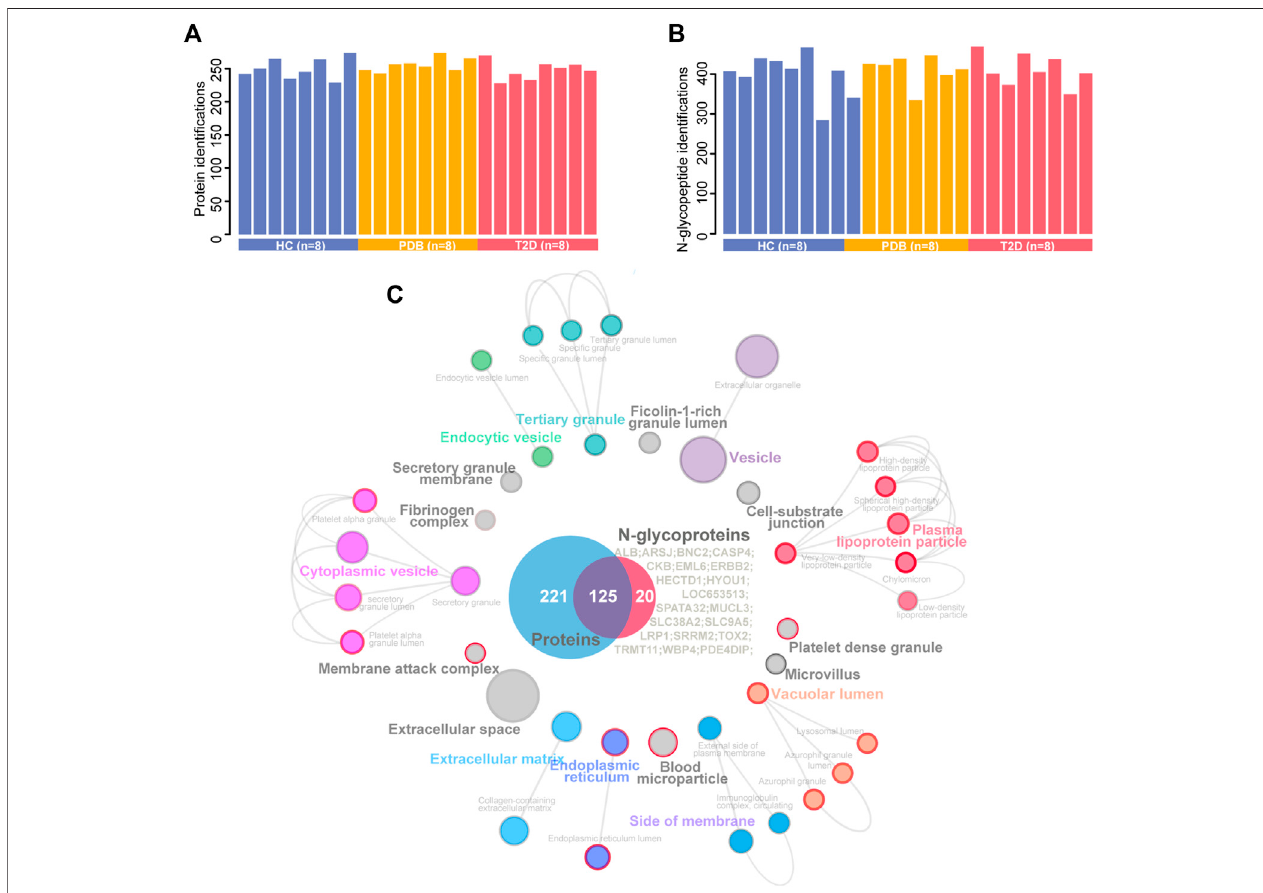
FIGURE 2 | A summary of plasma proteomic and glycoproteomic analysis of our data. (A, B) Number of protein ( A ) and N-glycopeptide (B) identi fi cations in HC (blue), PDB (yellow), and T2D (red) samples. (C) Cellular localization landscape of all proteins identi fi ed in proteomic and glycoproteomic analyses. A Venn diagram of proteins identi fi ed inproteomics or glycoproteomics isshown inthe center of thepicture,and the proteins exclusivelyidenti fi ed in glycoproteomicsare listed on the right of the Venn diagram. Cellular component interaction network of all proteins was constructed by the ClueGO app in Cytoscape software, based on Gene Ontology (GO) Cellular Componentdata resource.The component terms are connected based on the kappa score. The networkmodules are de fi ned using the kappa score and annotated with different colors. For each module, the most signi fi cant pathway is highlighted by a colored name label. The size of the nodes indicates the number of identi fi ed proteins with this component. The components speci fi cally enriched in glycoproteomics are labeled with a red node border.